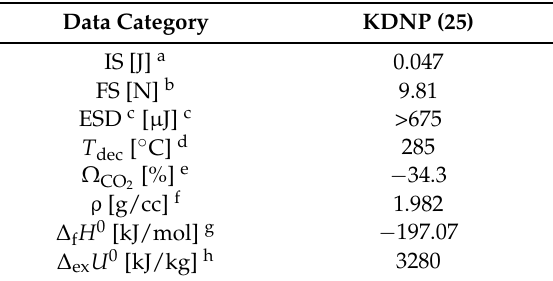
Table 2. Sensitivities and performance of KDNP (25).